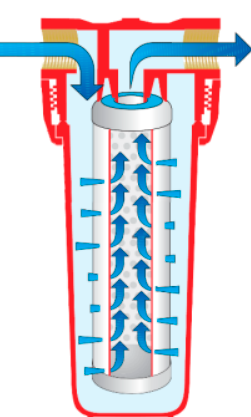
Figure 2. Fluid flow mode in the wire-wound filter cartridge: radial flux.